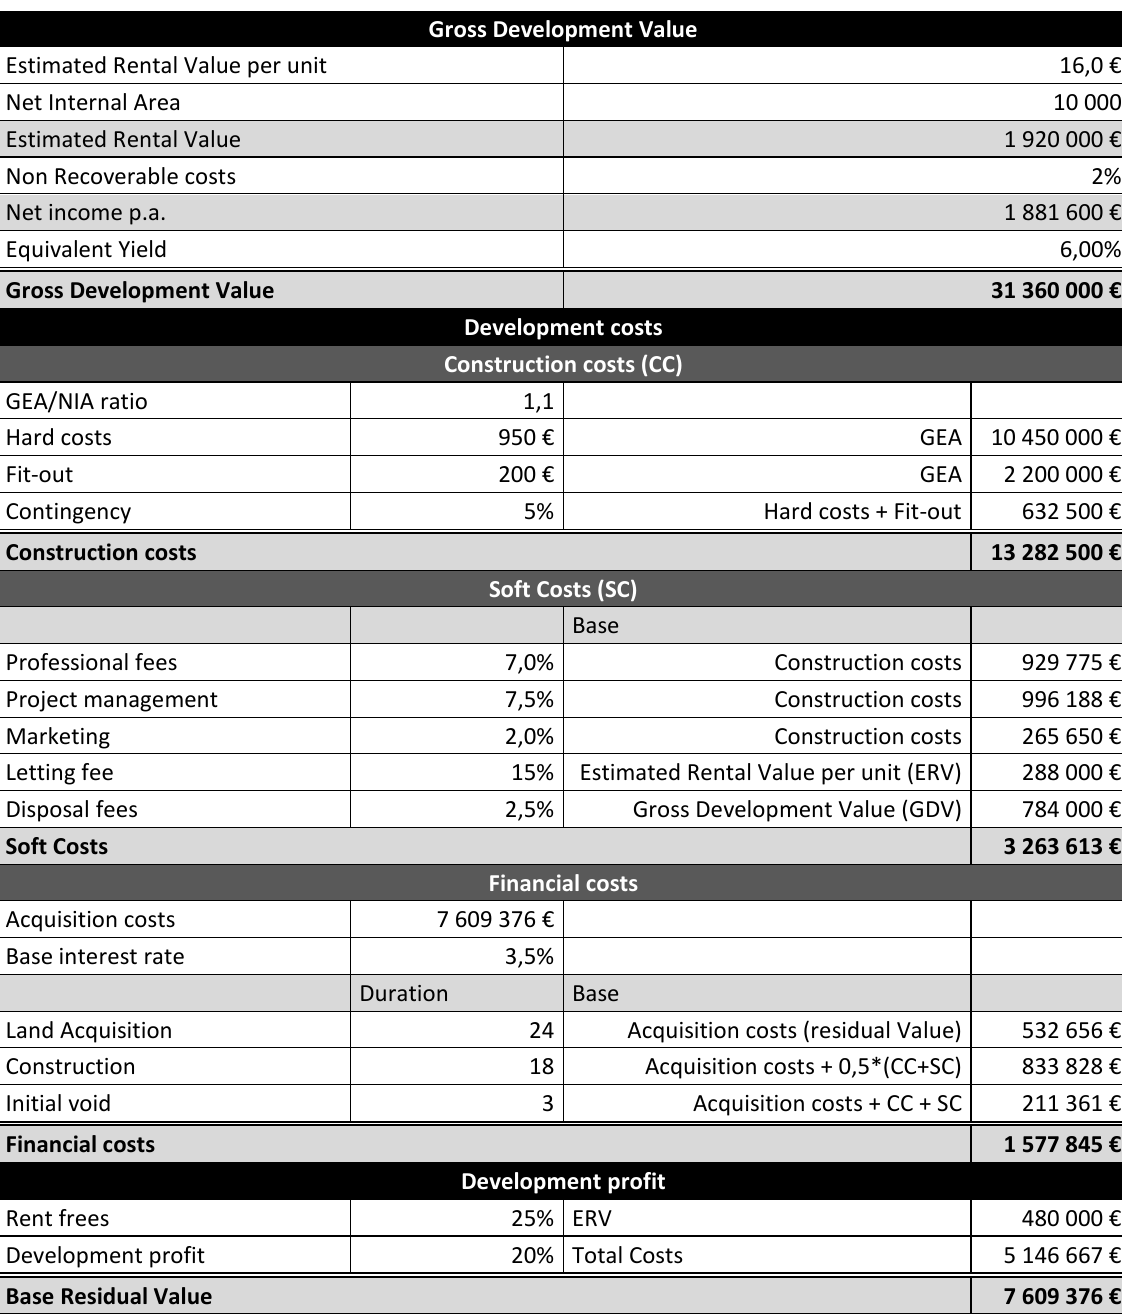
Table 1: Base Residual Value calculation (source: author)